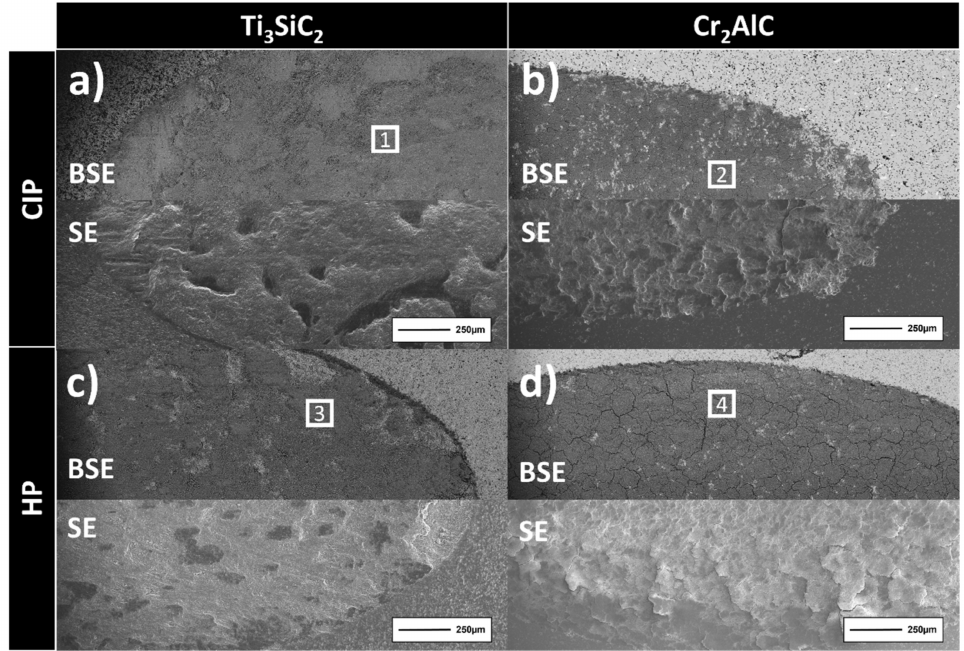
Figure 17. SEM secondary electron and back-scattered detectors micrographs of the reciprocating- sliding wear test with an applied load of 10 N for ( a ) cold isostatic pressed and sintered (CIP) Ti 3 SiC 2 ; ( b ) cold isostatic pressed and sintered (CIP) Cr 2 AlC; ( c ) hot-pressed (HP) Ti 3 SiC 2 and ( d ) hot-pressed (HP) Cr 2